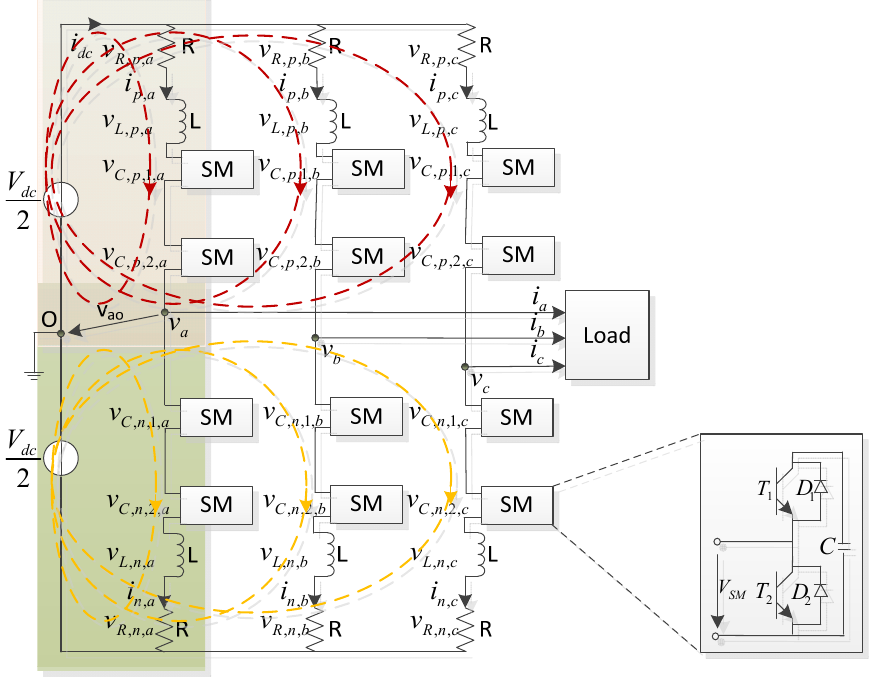
Figure 2. Structure of the Modular Multilevel Converter